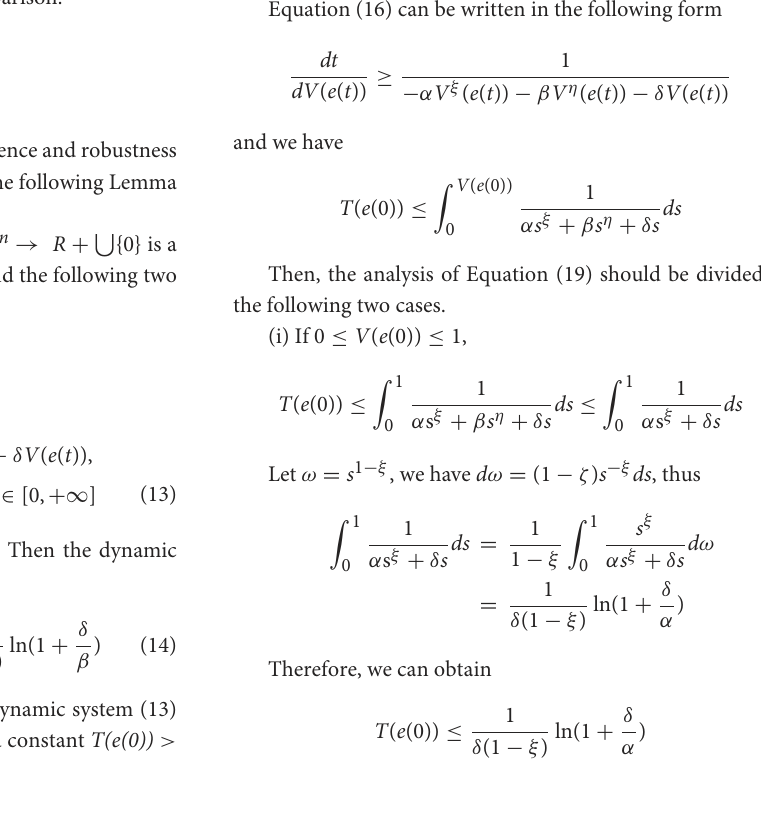
The corresponding algorithm diagram of the FTCRNN model for solving TODSE problem is presented in Figure 11.